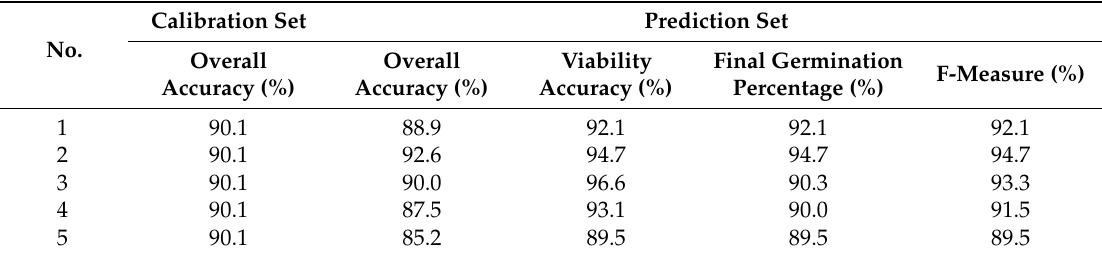
Table 4. Results of the models based on different proportions of the ventral groove side and reverse side.